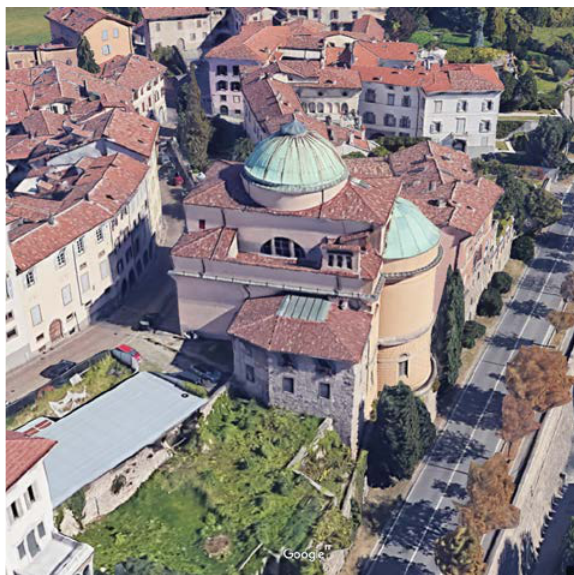
Figure 4. Aerial view of the church of Sant’Andrea.